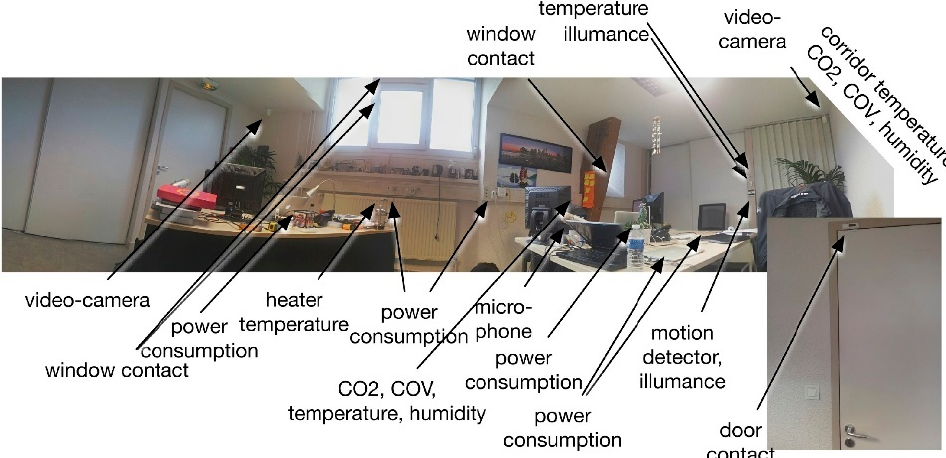
Figure 10. The deployment of the sensor network in the test bed of Ref. [125].